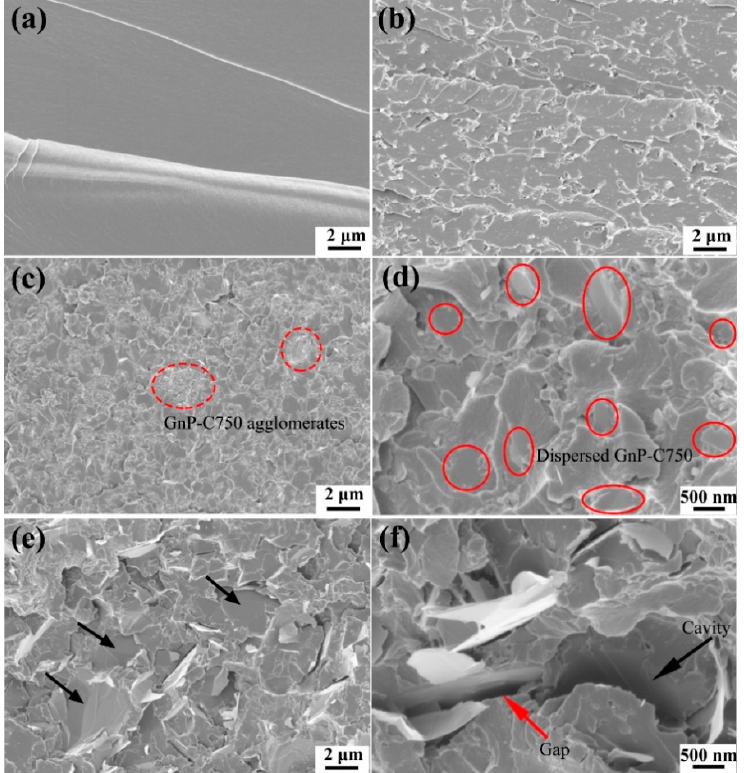
Figure 7. SEM images of the tensile fractured surfaces of ( a ) neat epoxy, ( b ) PES/epoxy, ( c ) 3 wt % GnP-C750/PES/epoxy, ( d ) 3 wt % GnP-C750/PES/epoxy (magnified), ( e ) 3 wt % GnP-5/PES/epoxy, ( f ) 3 wt % GnP-5/PES/epoxy (magnified).